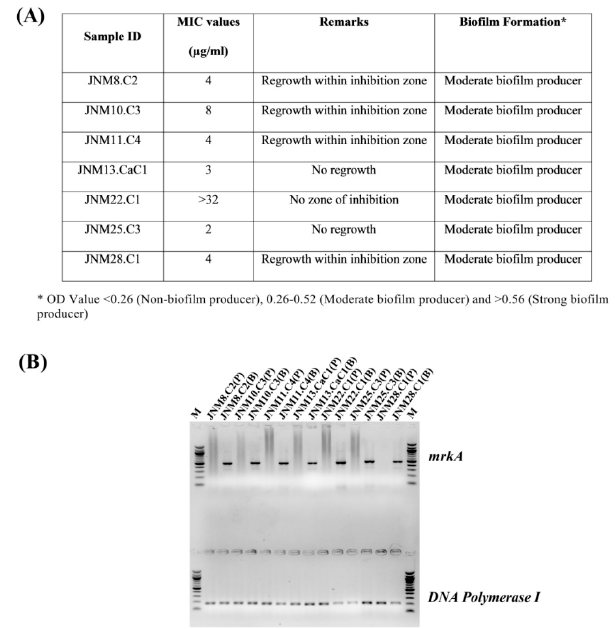
Figure 1. Characteristics of the K. pneumoniae clinical isolates. (A) Summary of the meropenem MIC values and biofilm forming abilities. (B) Validation of biofilm formation in 96-well static cultures after 24 hours using mRNA expression markers. The mrkA semi-quantitative RT-PCR products, 475 bp in size, were run on the wells above and the DNA polymerase I amplicons, 186 bp in size served as controls and were run on the lower lanes of a 1.5% agarose gel. M; 100 bp marker, P; planktonic cells, B; biofilm-forming sessile cells. All the bacterial cells recovered from biofilms across isolates expressed the mrkA gene while none of the planktonic cells had any detectable expression of the